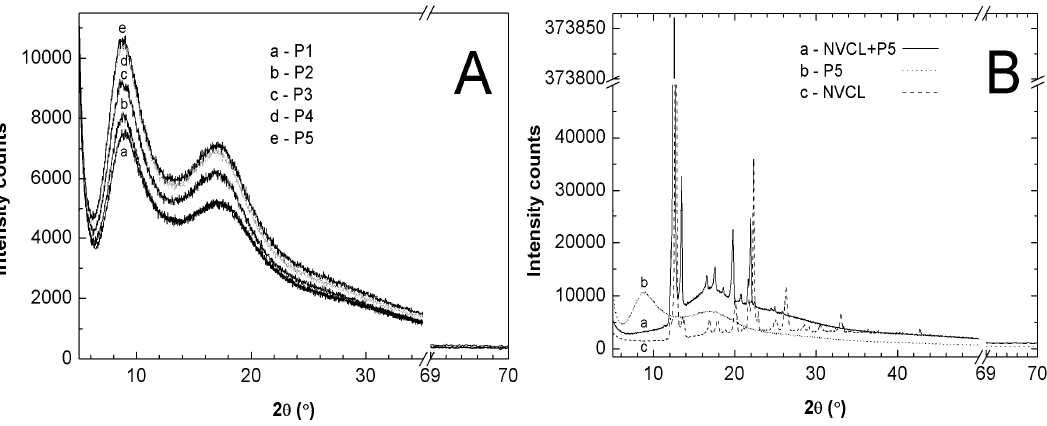
Figure 11. Powder X-Ray Diffraction of powder samples: ( A ) five samples of synthesized polymers P1, P2, P3, P4, and P5, and of ( B ) polymer P5, monomer NVCL, mixture NVCL+P5.